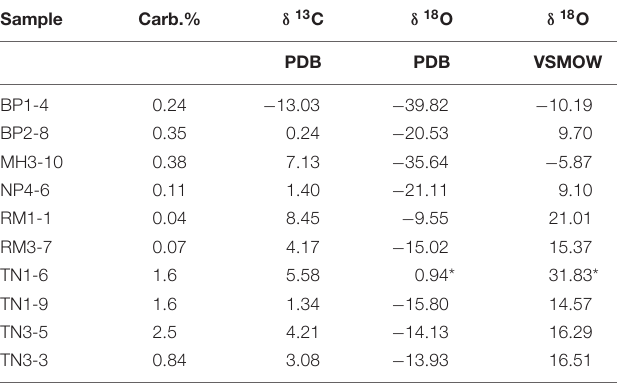
addition to Na(K)-NO 3 , which is observed in the SEM images of Schroeder Hill ( Figure 5